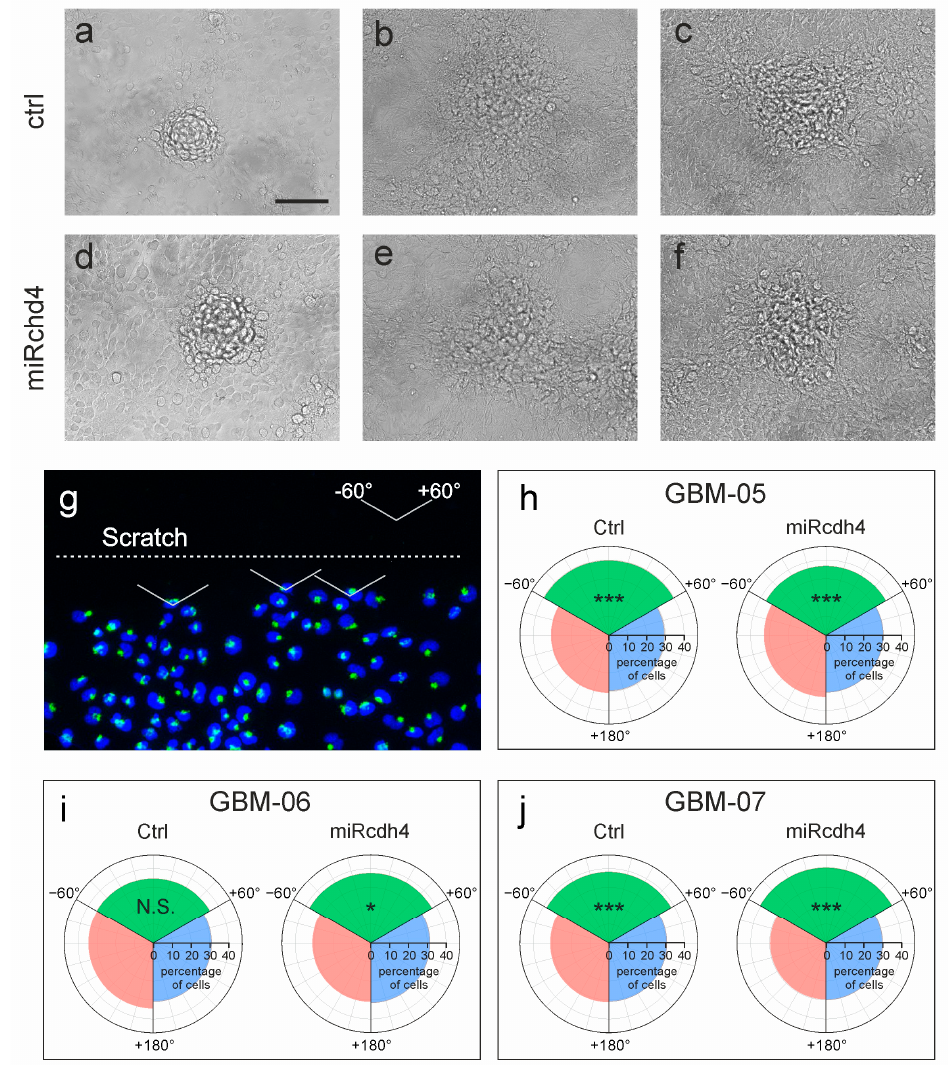
Figure 4. Effect of Cdh4 silencing on contact inhibition. ( a – f ) Bright field micrographs showing over confluence cultures of different Cdh4 silenced or control transduced human GICs. Scalebar: 500 µm. ( g – j ) Analysis of cell polarization of Cdh4 silenced GICs. ( g ) Example of the cell polarization analysis. Golgi apparatus was shown in green with anti-GM-130 antibody and nuclei in blue by Hoechst staining. ( h – j ) Polar histograms represent the migration directions of the cells close to the rim scratch. Cells with migration direction between − 60° and +60° were considered polarized toward the scratch (green sector). χ 2 test was used to assess whether the cells of each population were biased toward the scratch. * p < 0.05,*** p < 0.001.